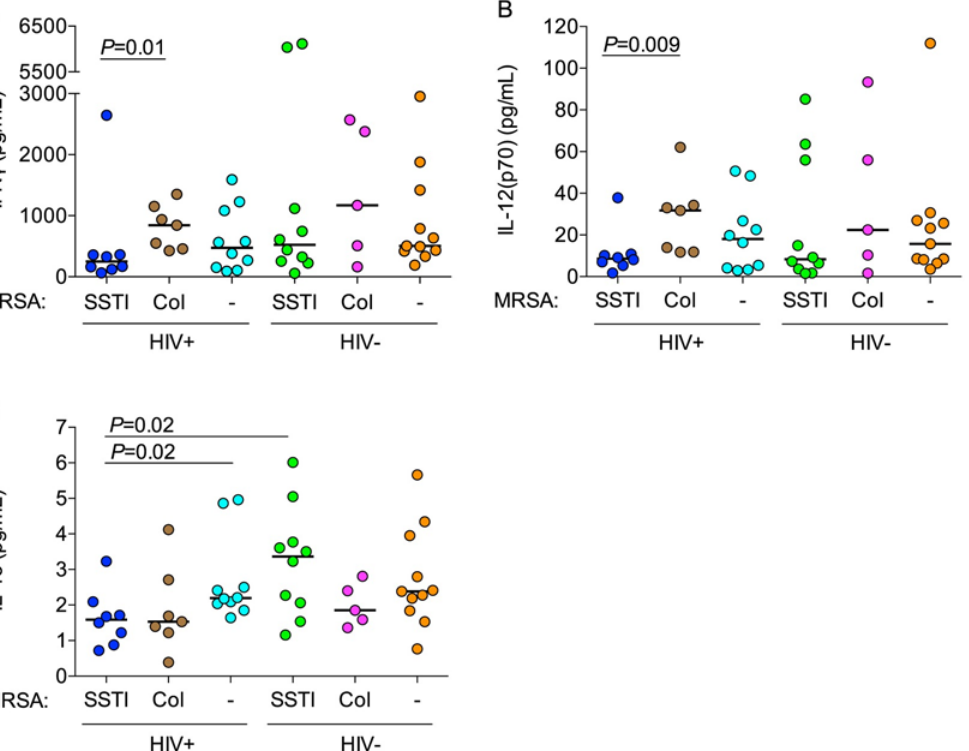
Fig 2. Cytokine concentrations released into supernatant. Supernatant concentrations of IFN γ (A) and drivers of IFN γ production, IL-12 (B) and IL-15 (C), after MRSA stimulation of PBMCs were assayed using the Luminex platform. P -values were calculated using the Mann-Whitney U test.